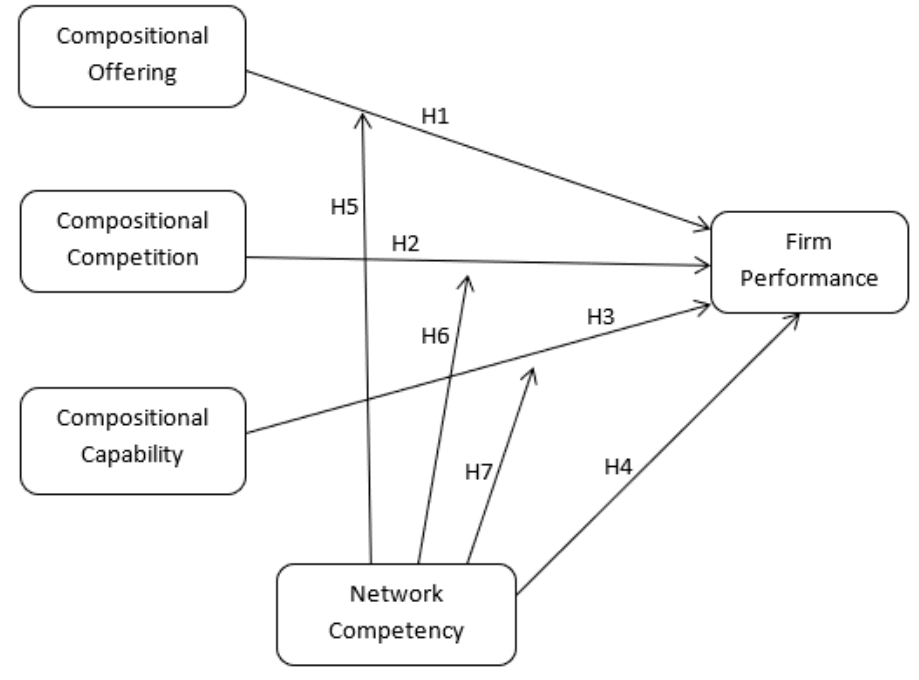
Figure 1: Conceptual